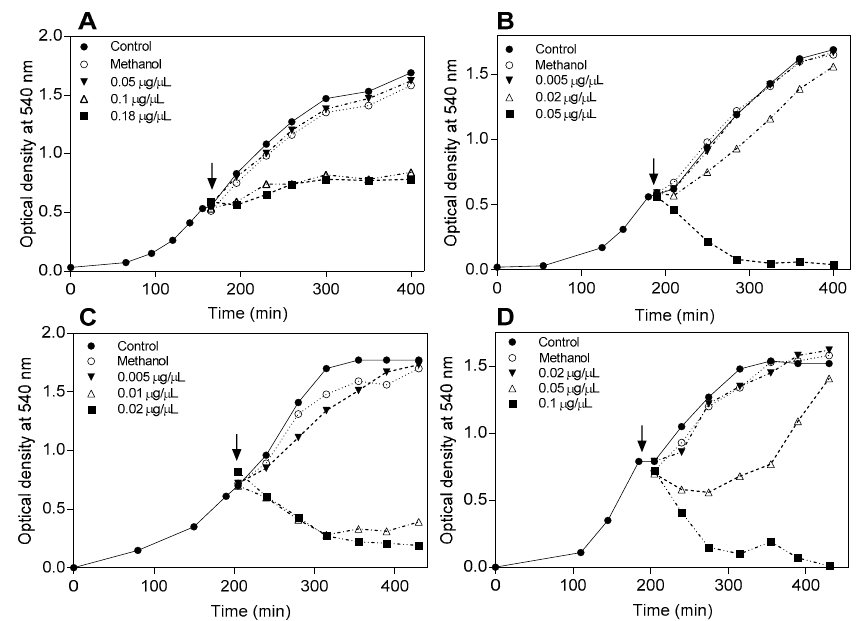
Figure 3. Effect of flavonoids on bacterial exponential growth and viability. 10 mL E. coli ( A ) and B. subtilis ( B – D ) cultures at O.D. 540 nm 0.5 (shown by the arrow) were treated with different concentrations (indicated in the figure) of pinocembrin ( A , B ), 3- O -methylgalangin ( C ), and 7- O -methyleriodictyol ( D ), or the cells were not treated or they were treated with methanol alone. The graphs are representative of the results of three replicates.